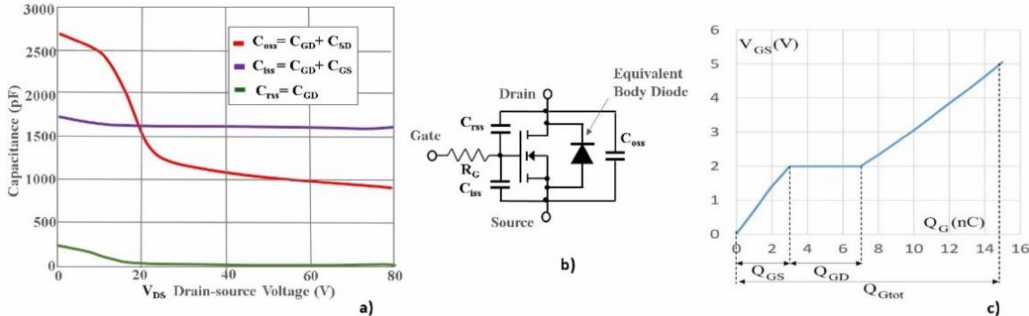
Figure 2. ( a ) Parasitic capacitors behaviour versus drain source voltage (VDS) variation. ( b ) GaN FET model with parasitic capacitors, inner gate resistor and equivalent body diode symbol. ( c ) Gate charge of 80 V 1.8 m Ω HEMT GaN FET